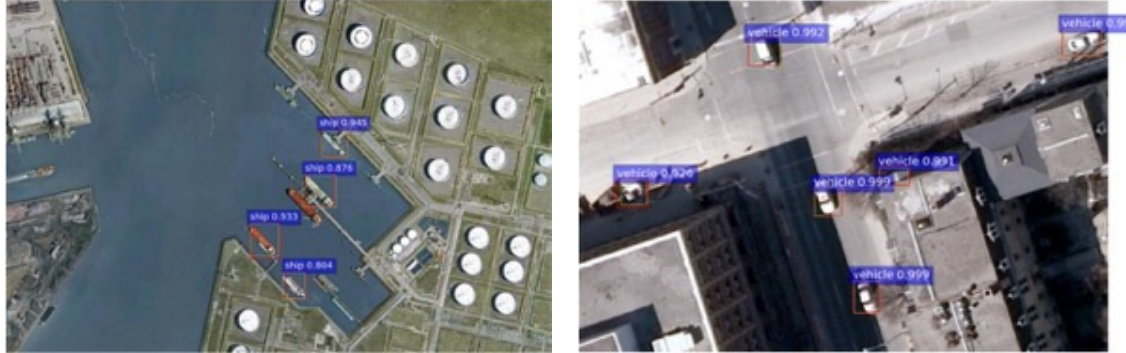
Figure 8. Evaluation of the accuracies of MdrlEcf in locating the objects.